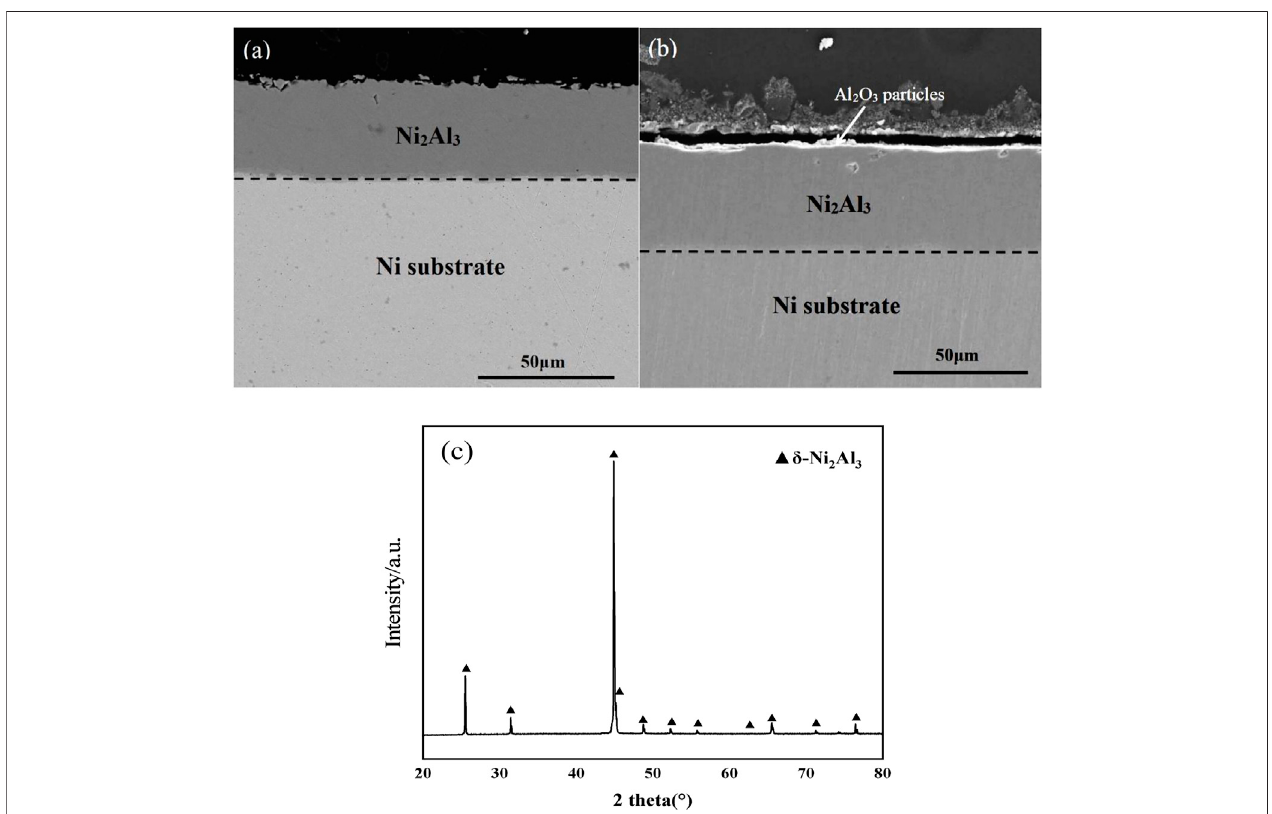
FIGURE 1 | Cross-sectional morphologies of Ni 2 Al 3 coatings (A) naked, (B) with an Al 2 O 3 fi lm on the surface, and (C) XRD pattern of the naked Ni 2 Al 3 coating.